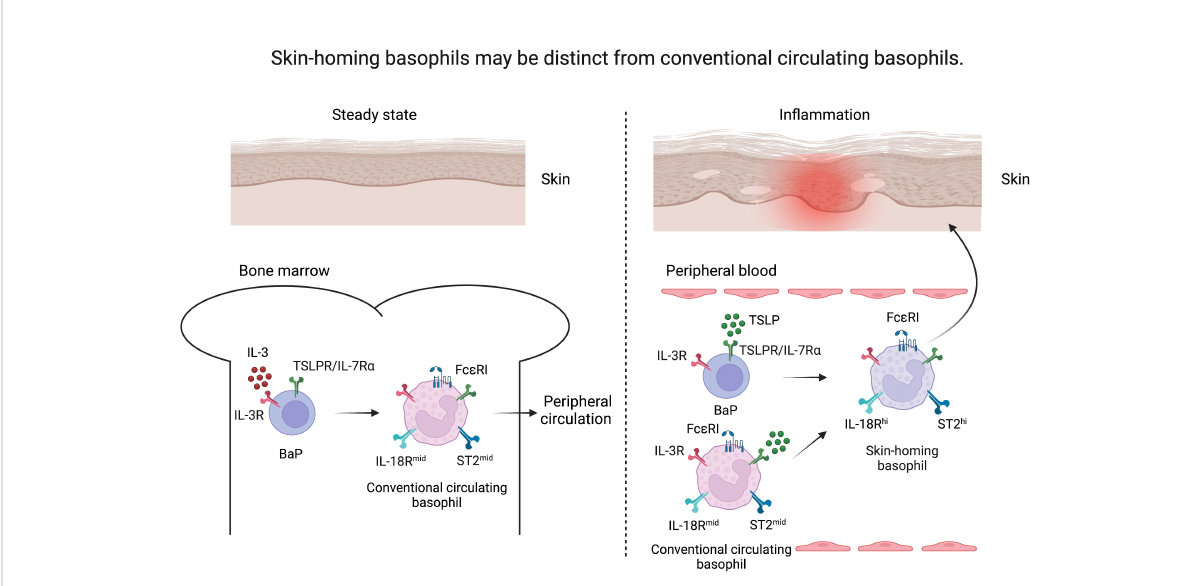
FIGURE 1 Skin-homing basophils may be distinct from conventional circulating basophils. Under steady state, basophil progenitors (BaP) develop into Fc ϵ RI hi basophils under the in fl uence of IL-3 in the bone marrow (conventional circulating basophils, left). Upon in fl ammation, TSLP released from the skin drives the maturation of BaPs to exhibit a highly activated phenotype (skin-homing basophils, right) as evidenced by upregulation of IL-18R and ST2 in comparison to IL-3-elicited